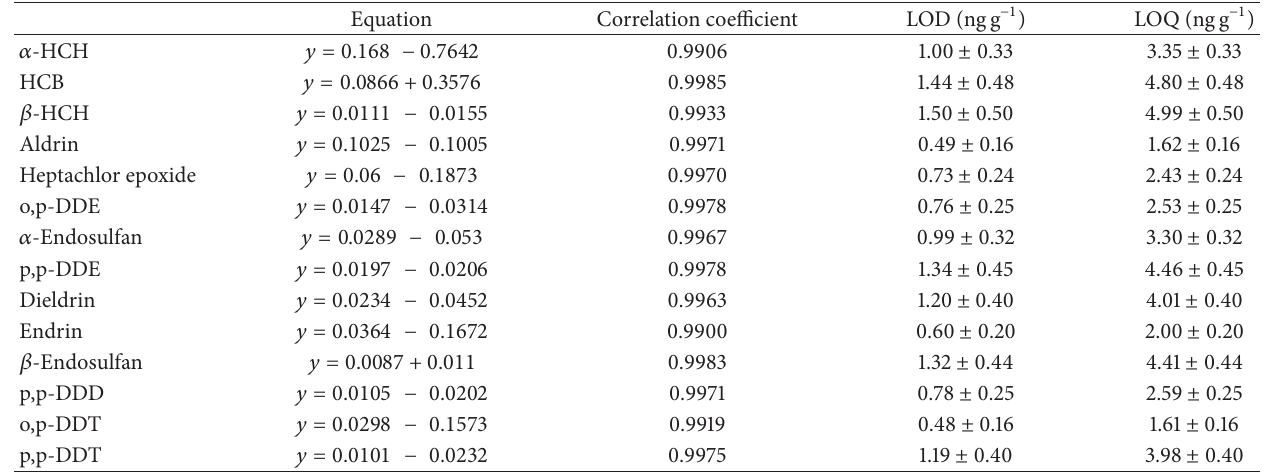
Table 2: Linearity, LODs, and LOQs of OCPS after SPME procedure. Equation Correlation